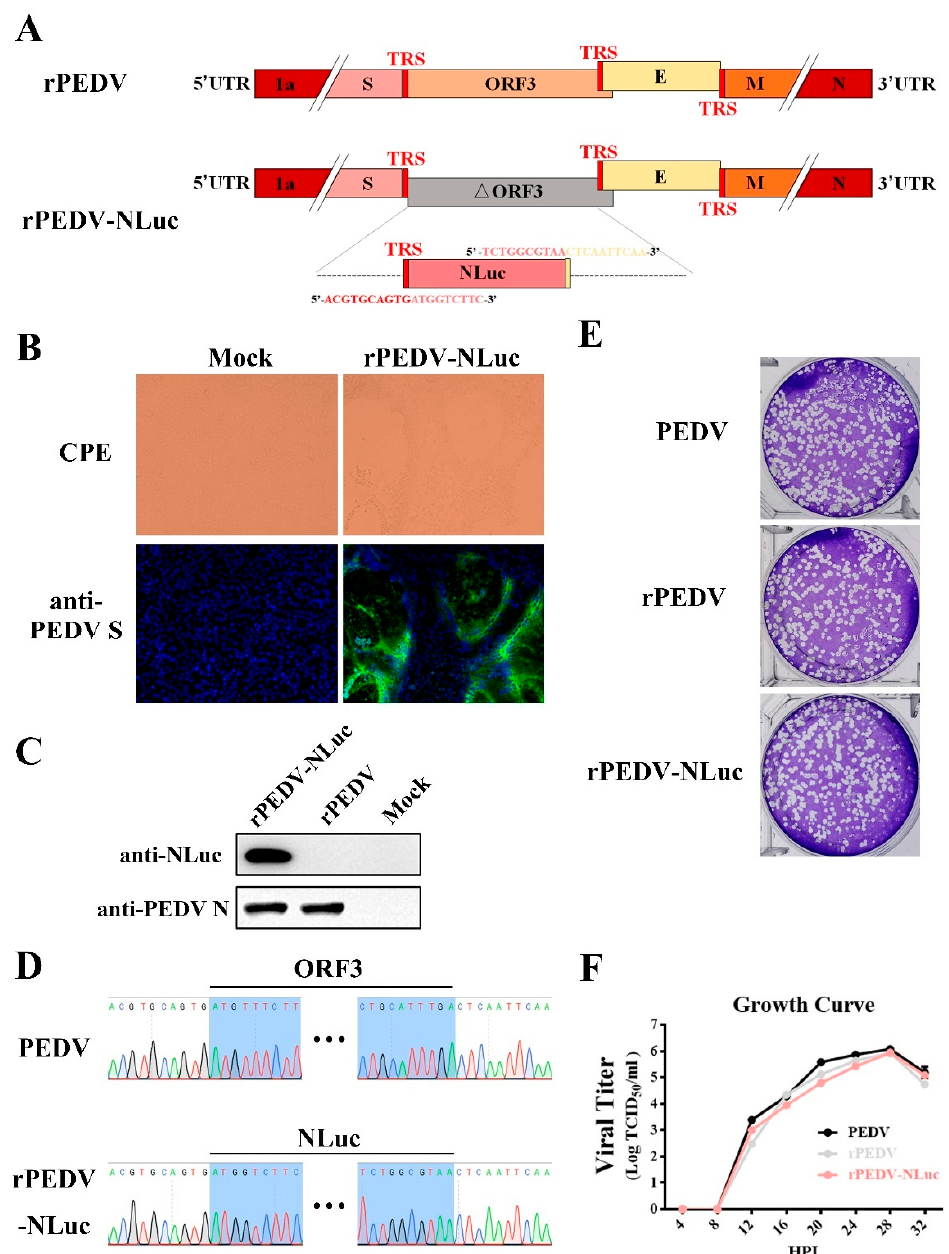
Figure 2. Rescue of rPEDV-NLuc. ( A ) Schematic representation of the cDNA clone of rPEDV-NLuc. ( B ) The rPEDV-NLuc- and mock-infected Vero cells were detected by IFA using anti-PEDV S mAb 4B2 (magnification, ×100). ( C ) Western blot analysis of the expression of PEDV N and NLuc using the anti-PEDV N mAb 8E2 and the anti-NLuc mAb 5H6, respectively. ( D ) Identification of the ORF3 replacement with NLuc by sequencing the rPEDV-NLuc genome. ( E ) Representative plaques of wild-type PEDV-, rPEDV-, and rPEDV-NLuc-infected Vero cell. ( F ) Comparison of growth kinetics of wild-type PEDV, rPEDV, and rPEDV-NLuc. Vero cells were infected with wild-type PEDV, rPEDV, and rPEDV-NLuc at an MOI of 0.01, and viral titers were detected at indicated time points by TCID 50 assay. Data are represented as the mean ± SD (n = 3).